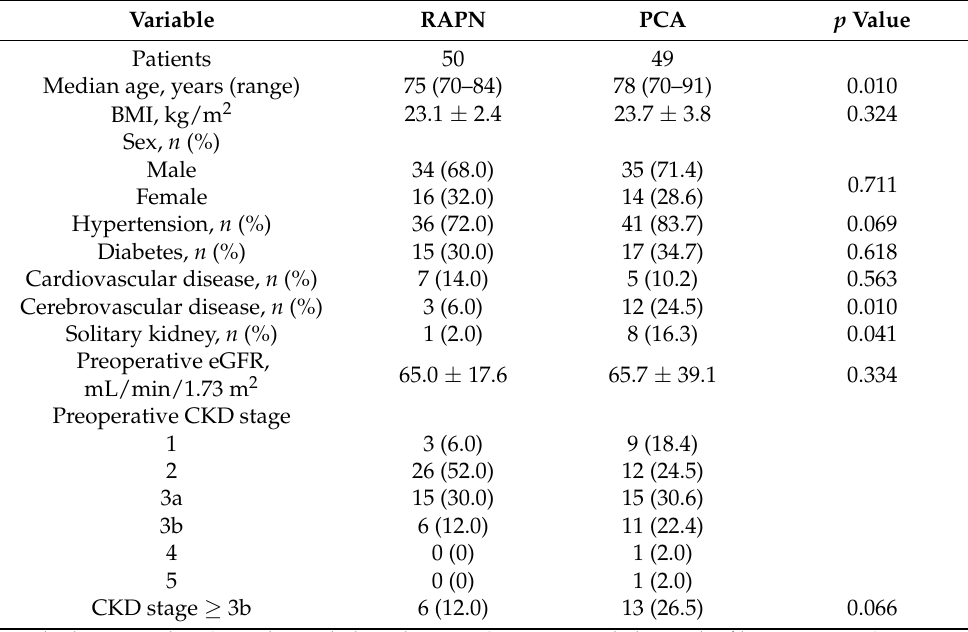
Table 1. Patient characteristics and preoperative renal function. Variable RAPN PCA p